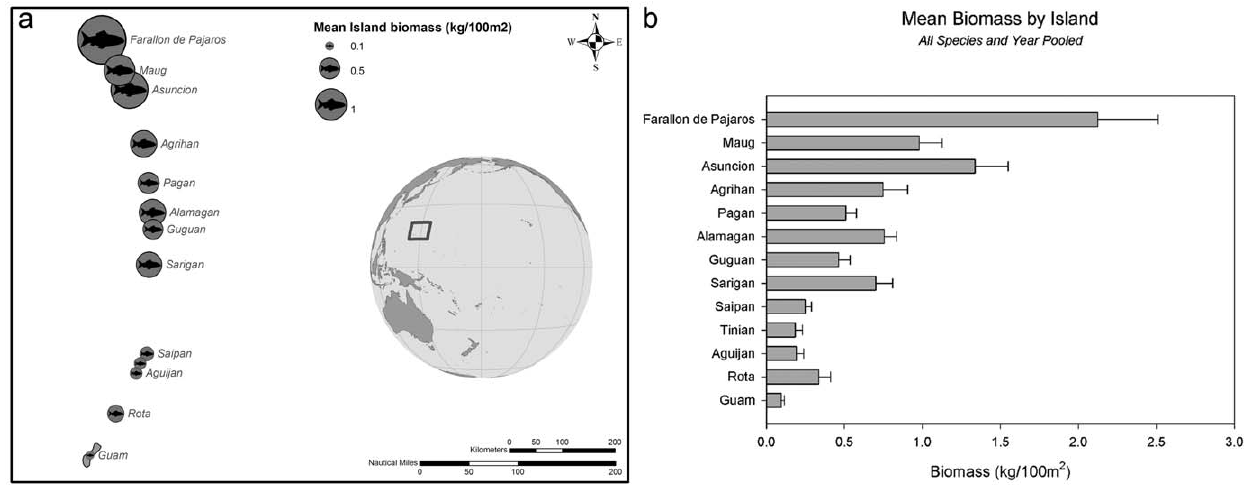
Figure 2. Biomass of large-bodied reef fish (all species and years pooled) in the Mariana Archipelago. Error bars are 1 standard error.